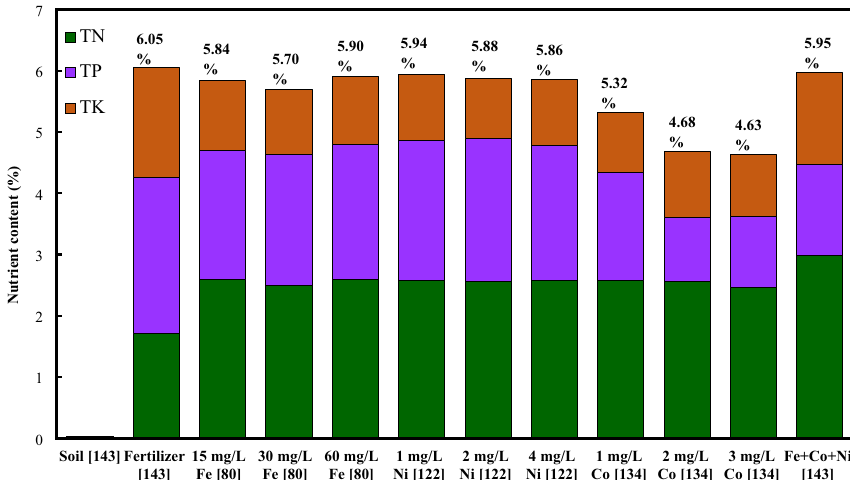
Fig. 2 The nitrogen, phospho- rous, and potassium contents of soil, commercial bio-organic fertilizer and the effluent with different nanoparticle concen-